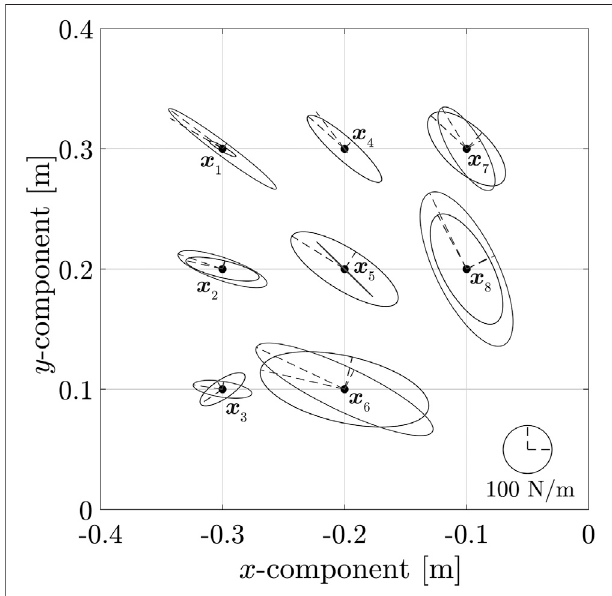
FIGURE5| Changeinorientationofmajoraxisofellipsoidwithend-point position.